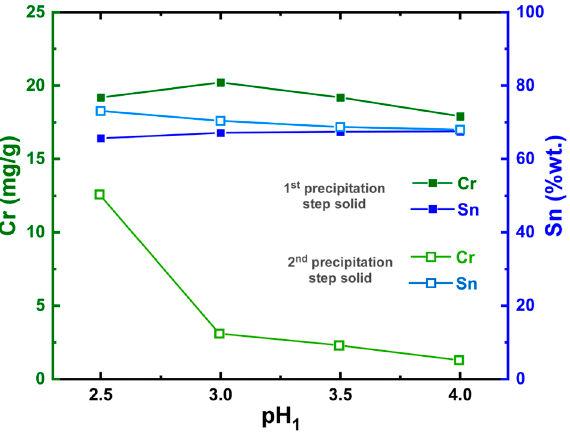
Figure 8. Influence of pH in the 1st precipitation step (pH 1 ) to the Sn and Cr content in solids produced at reconstruction process.